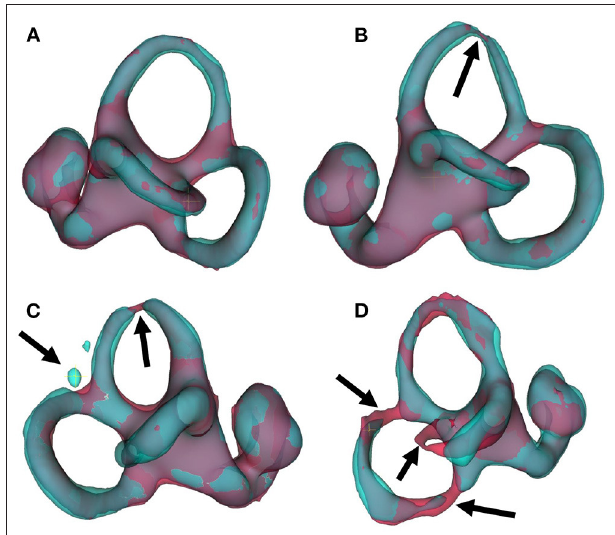
FIGURE 6 | IE-Vnet 3D segmentation predictions visualized. Visualization of 3D segmentations predicted by the IE-Vnet model (color: cyan), overlaid onto manual ground-truth 3D surface contours (color: red). (A) Exemplary case of a highly accurate segmentation Dice > 0.92, Hausdorff maximum surface distance < 0.5 mm, mean surface distance < 0.02 mm, 5/5 Likert scale (LS) for cochlea, sacculus, utriculus, anterior, posterior and horizontal SCC. Manual ground-truth and prediction are in high agreement over the entire surface. (B) Another example of a highly accurate segmentation. The arrow denotes a location with hypo-intense semi-circular canal voxels, as marked manually in red, and the model prediction predicts a thinning at the same location. LS was 5/5 for cochlea, sacculus, utriculus, anterior, posterior and horizontal SCC. (C) An exemplary case of an overall accurate segmentation, but with a high Hausdorff surface distance of > 4 mm. LS was 5/5 for cochlea, sacculus, utriculus, posterior and horizontal SCC, and 2/5 for anterior SCC. Visual inspection reveals two isolated blobs, which could be removed with simple post-processing, such as connected components analysis and removal of small islands. (D) A failure case. Notably, manual ground-truth creation in this sample was challenging as well. LS was 5/5 for utriculus and anterior SCC, 4/5 for cochlea and sacculus, 2/5 for horizontal SCC, and 1/5 for posterior SCC. Low-contrast and high noise in SPACE sequences, with further potential challenges like motion artifacts, can lead to irregular ground-truth contours (left arrow) or unusually thin semi-circular canal segments (middle and right arrow). In such cases, model predictions may result in in-contiguous semi-circular canals and noisy surface